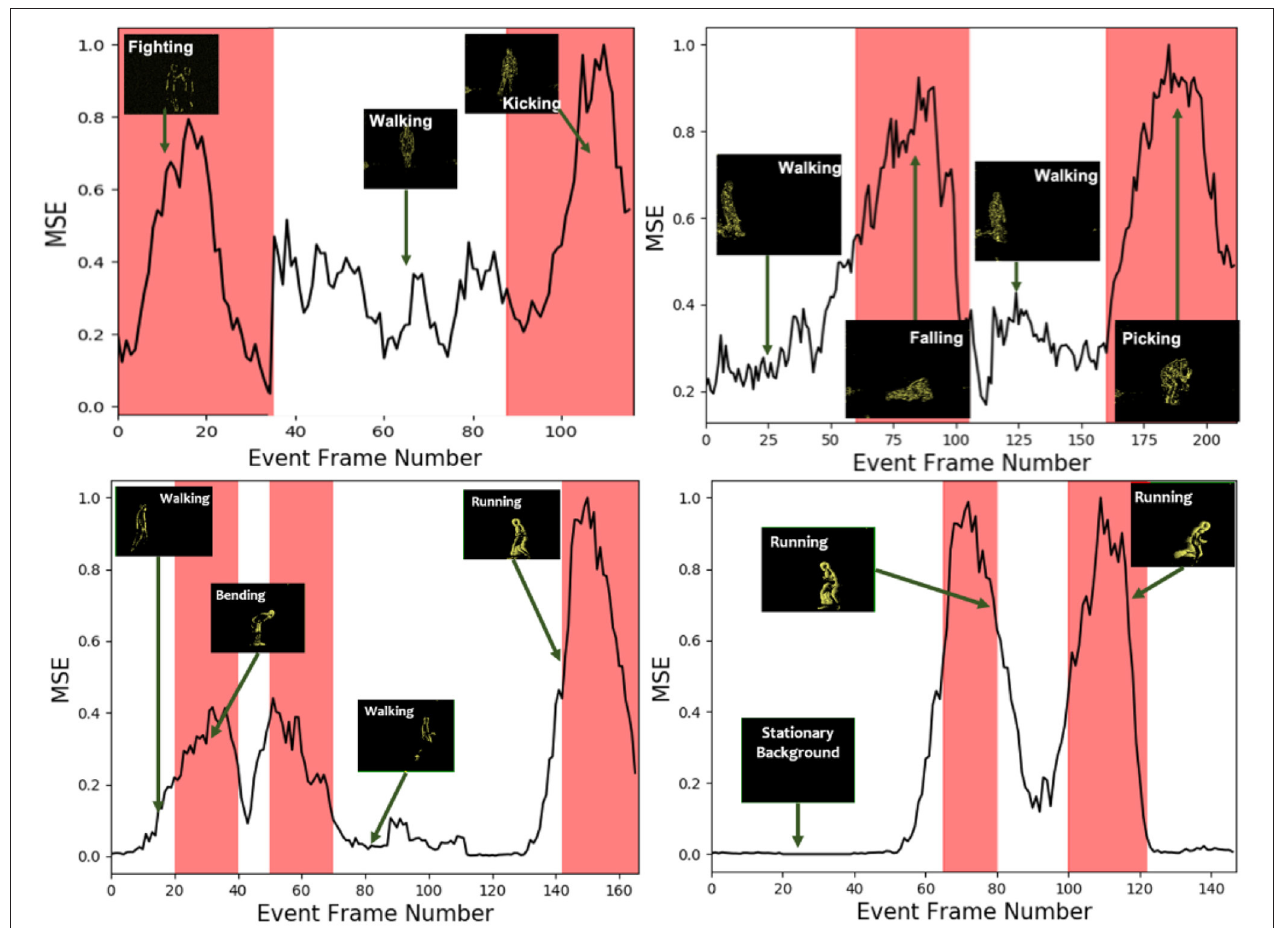
FIGURE 6 | Visualization of mean square error (MSE) between original and predicted Time Surfaces (TS). White color corresponds to a time frame of normal activity, and red corresponds to abnormal activity. Top left : Walking is a normal activity with kicking and fighting as anomalies. Top right : Walking is a normal activity, with falling and picking as an anomaly. Bottom left : Walking as normal with bending and running as an anomaly. Bottom right : Stationary background as normal with running as an anomaly. MSE is high during anomalous activities as the anomaly network cannot predict the future TS in those cases as it has not seen them during